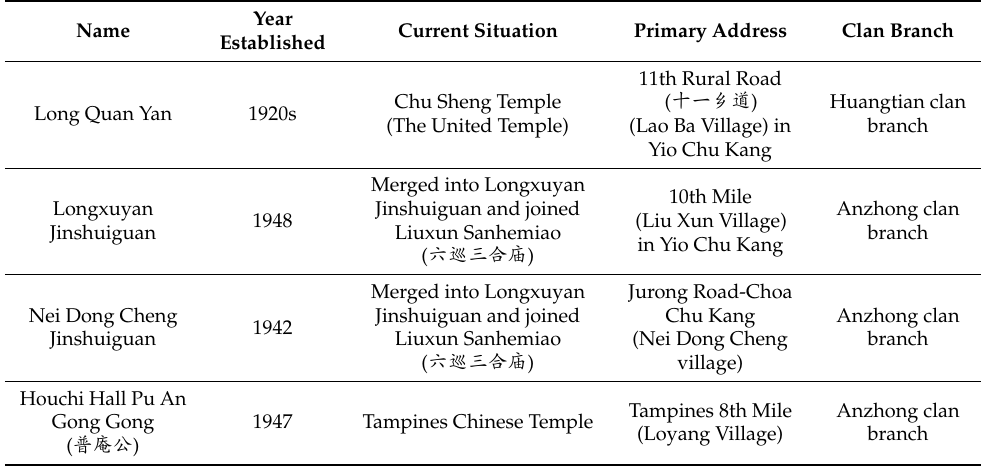
Table 4. Ancestral temples of Xiangyun Ong